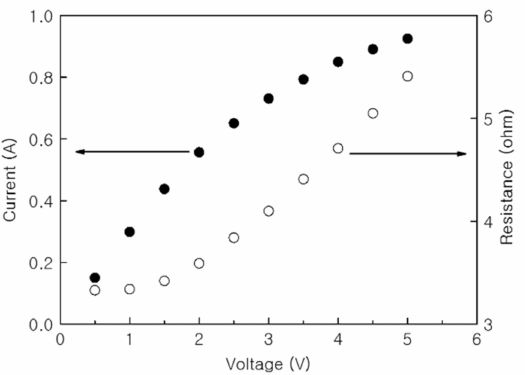
Figure 9. Current and resistance of the PTC-SHT according to applied